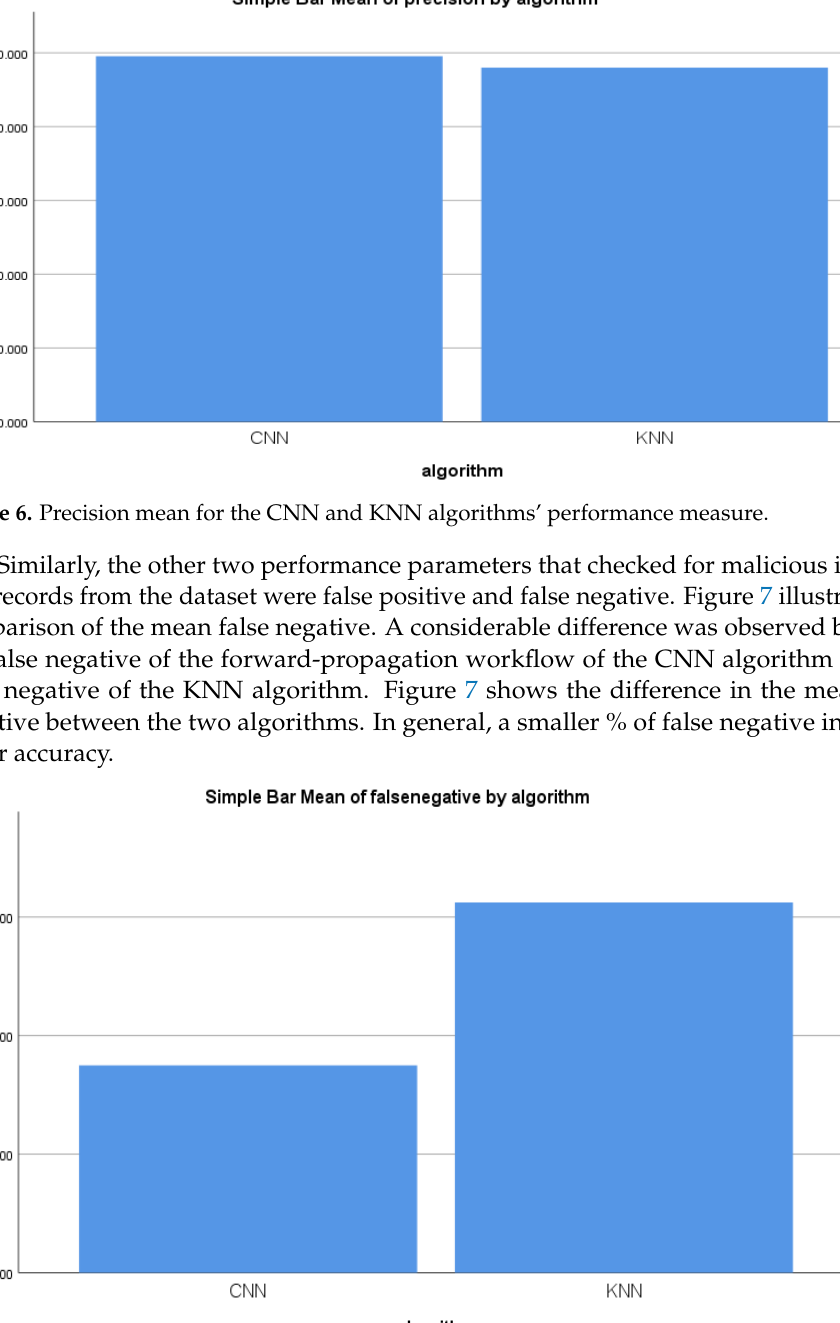
Figure 5. Accuracy mean for CNN and KNN performance measure.